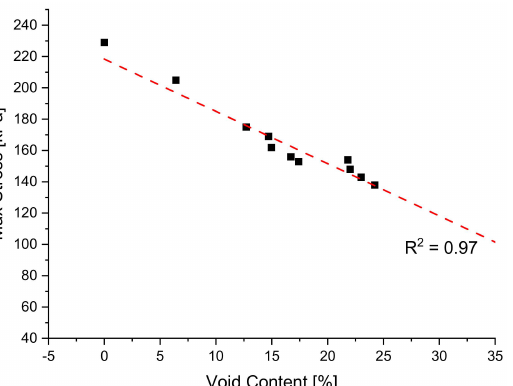
Figure 11. Depiction of the linear relationship between max stress experienced in relaxation testing and void content for blend 1.